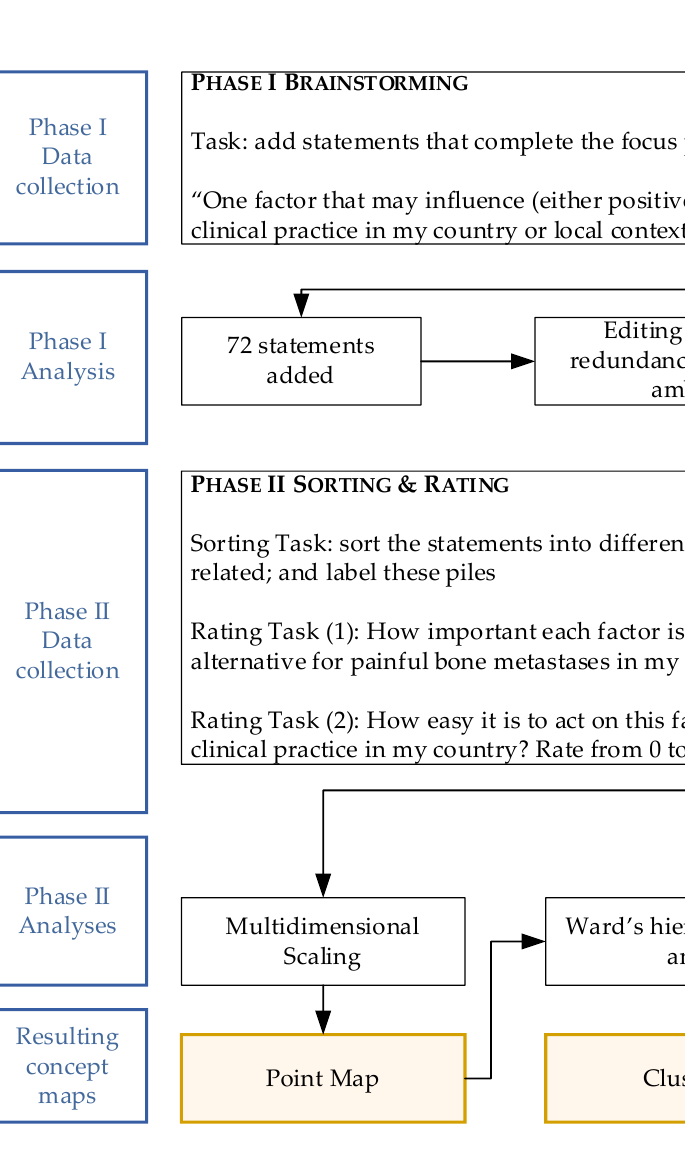
Figure 1. Overview of data collection and analysis for the GCM study. Participants are responsible for generating ideas (phase I) and organizing and structuring the ideas (phase II). a Performed by two researchers independently.